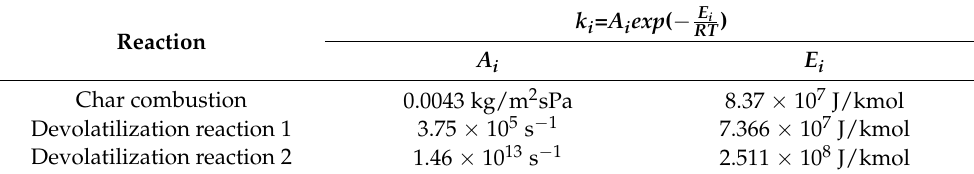
Table 1. Reaction kinetic parameters [30].